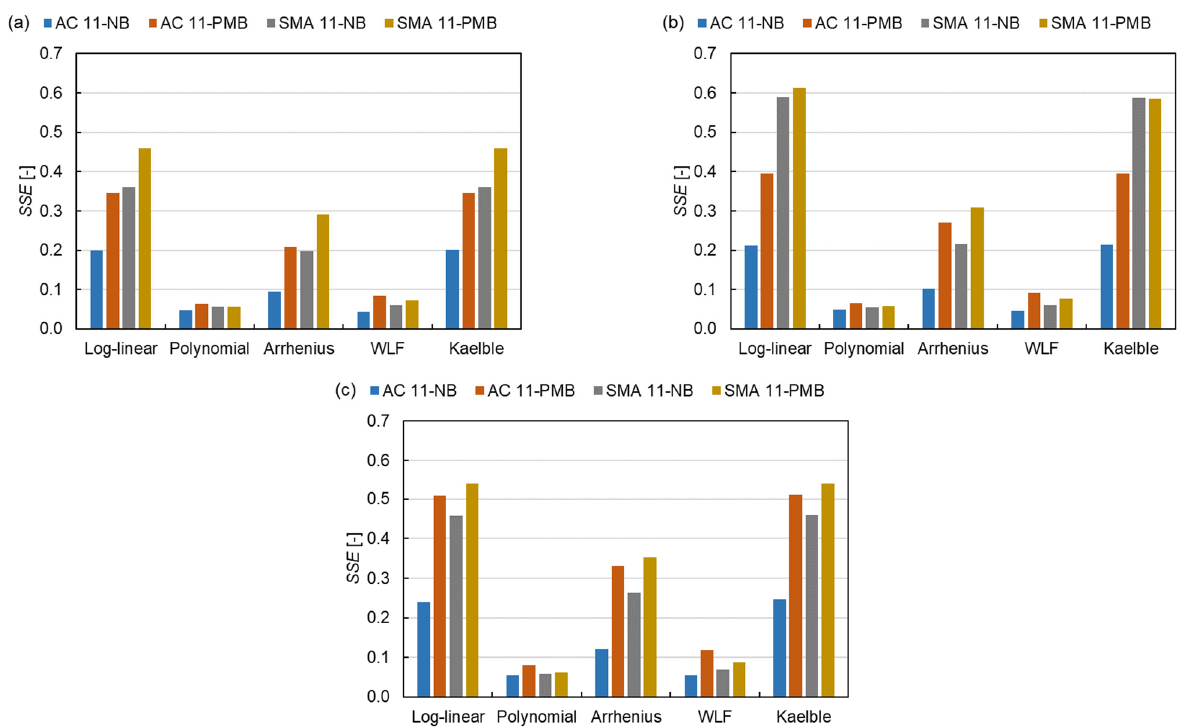
Figure 12. SSE of all fitting procedures: ( a ) SLS model, ( b ) GLS model and ( c ) CAM model.